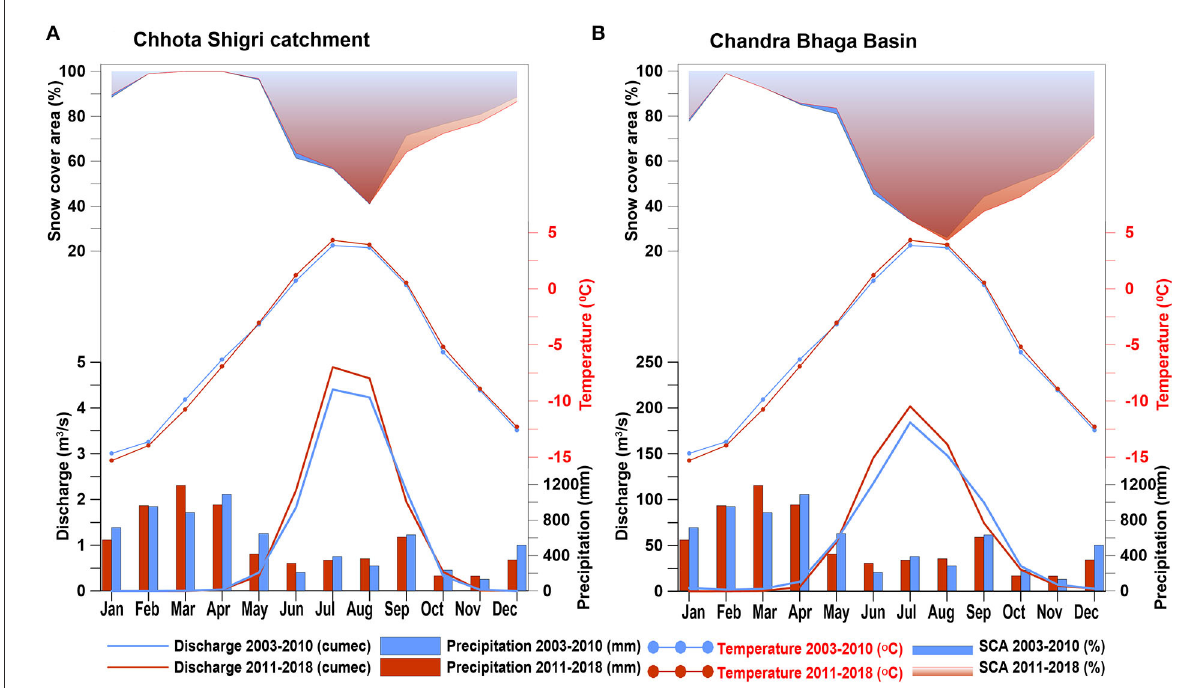
FIGURE11 Decadal comparison of discharge with precipitation, temperature, and snow cover area over the two time periods 2003–2010 (blue color) and 2011–2018 (red color) for Chhota Shigri Catchment (A) and Chandra-Bhaga Basin (B) .